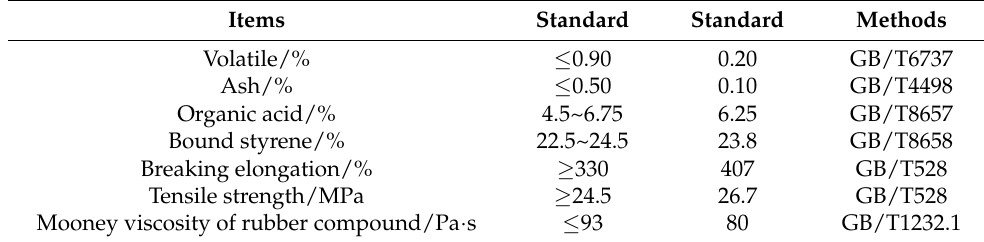
Table 2. Properties indexes of polystyrene–butadiene copolymer (SBR)